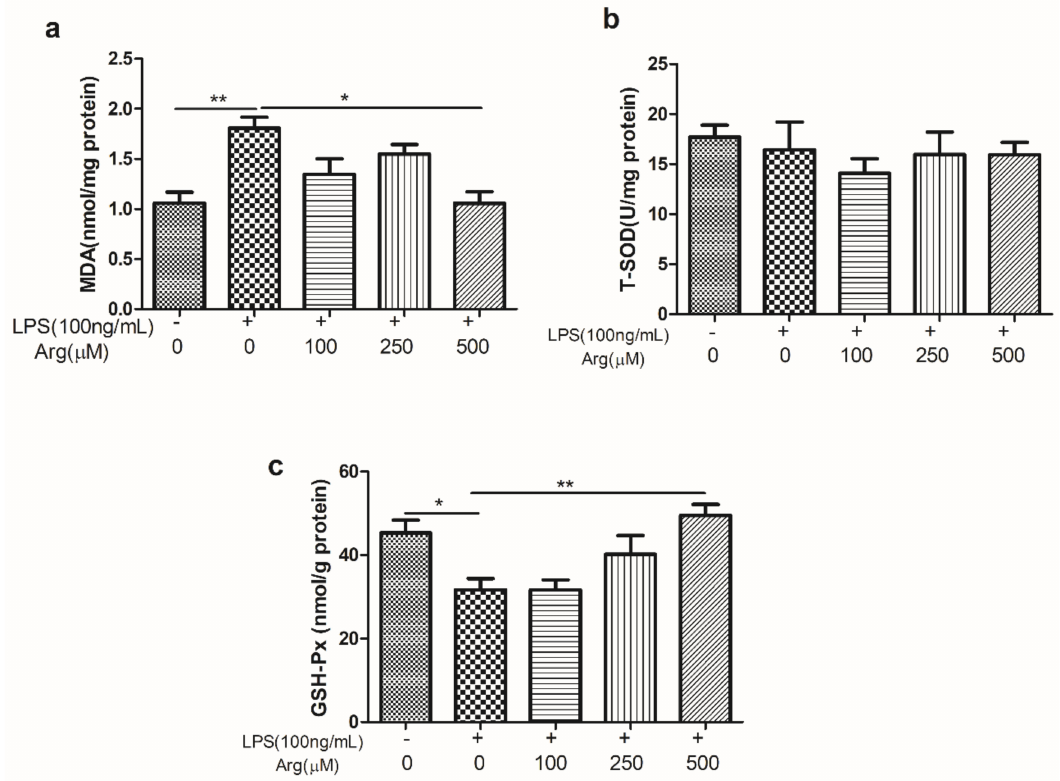
Figure 6. The e ff ect of L-arginine on contents of MDA, T-SOD and GSH-Px in LPS-stimulated IPEC-J2 cell. IPEC-J2 cells exposed to LPS (0 or 100 ng / mL) and LPS-treated cells were co-incubated with L-arginine (0, 100, 250, or 500 µ M) for 24 h, then the cells were collected to analyze the contents of ( a ) MDA, ( b ) T-SOD, and ( c ) GSH-Px. Data were representative of triplicate experiments and expressed as the mean ± SEM.* p < 0.05, ** p < 0.01. MDA, malonaldehyde; GSH-Px, glutathione peroxidase; T-SOD, total superoxide